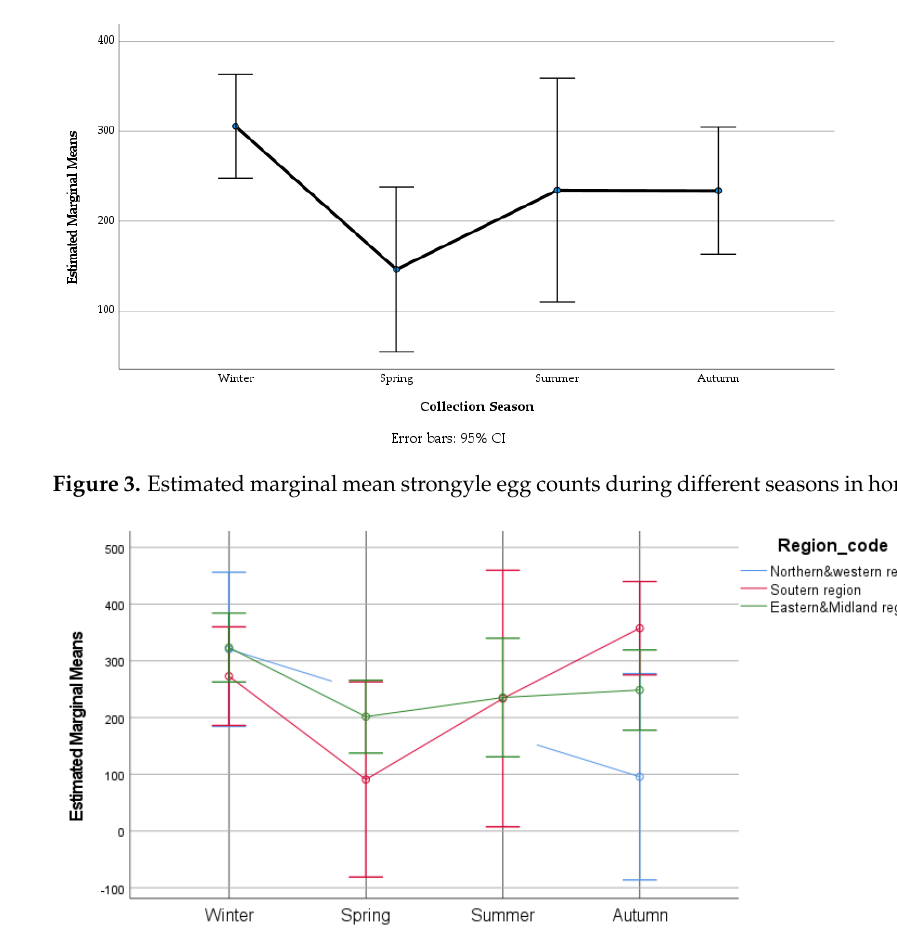
Figure 2. The estimated marginal mean strongyle egg counts for different genders and age groups.